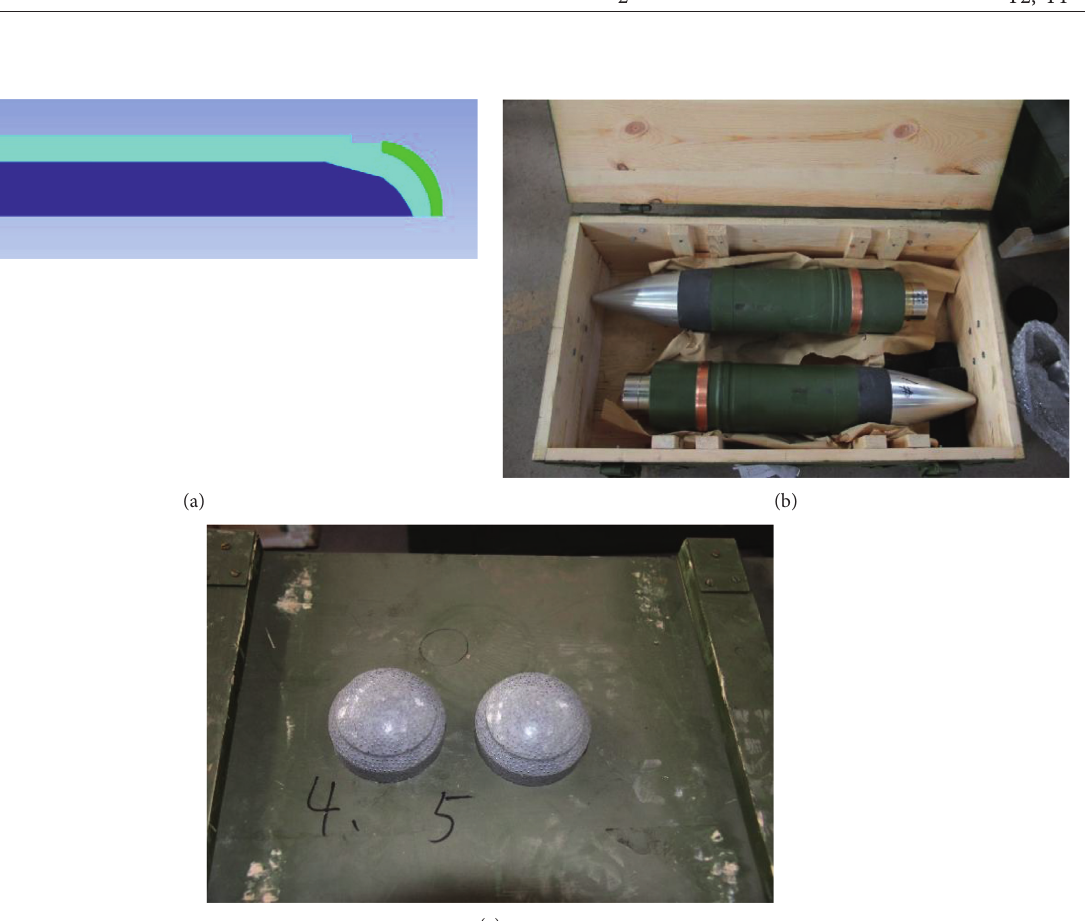
Figure 4: Schematic diagram of warhead: (a) warhead simplified diagram, (b) projectile body, and (c) tungsten ball